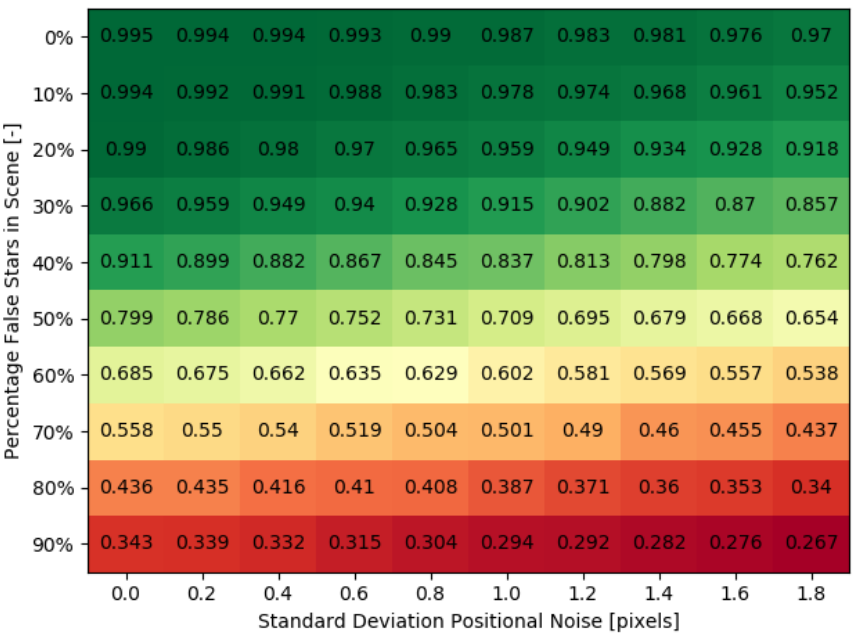
Figure 7. Network performance under a combination of noise factors. Numbers indicate identification